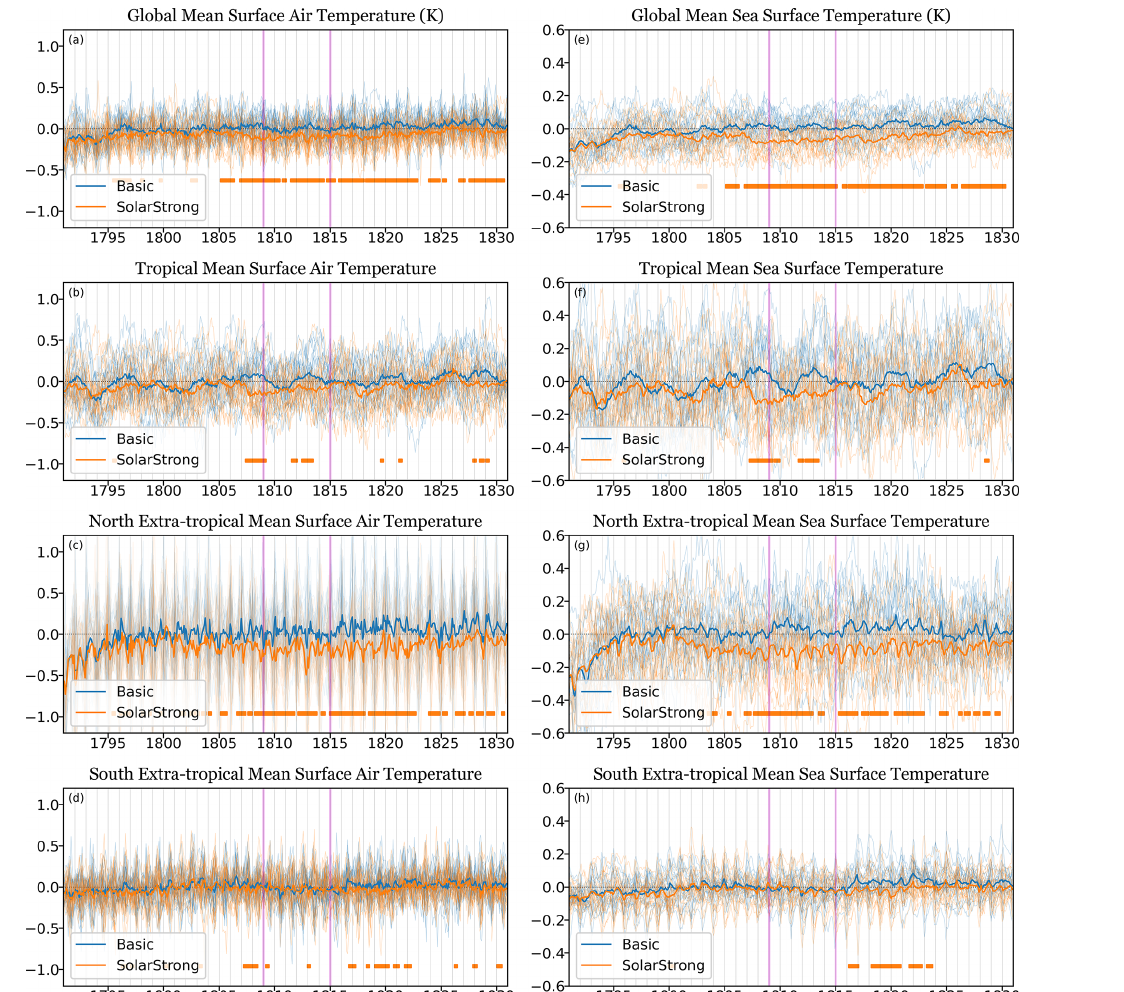
Figure 2. (a) Global mean SAT (K) anomalies of the Basic (blue) and SolarStrong (orange). (b) Tropical mean (30 ◦ S to 30 ◦ N), (c) northern extratropical mean (30 to 90 ◦ N), and (d) southern extratropical mean (90 to 30 ◦ S). (e) – (h) are for SST (K) and the same regions. The thick lines are the ensemble mean. The orange boxes below indicate periods during which the ensemble means of SolarStrong are significantly different (see Sect. 2 for details) to the Basic experiment. The magenta vertical lines indicate the year of 1809 and 1815 Tambora eruptions, other gray vertical lines are the January for each